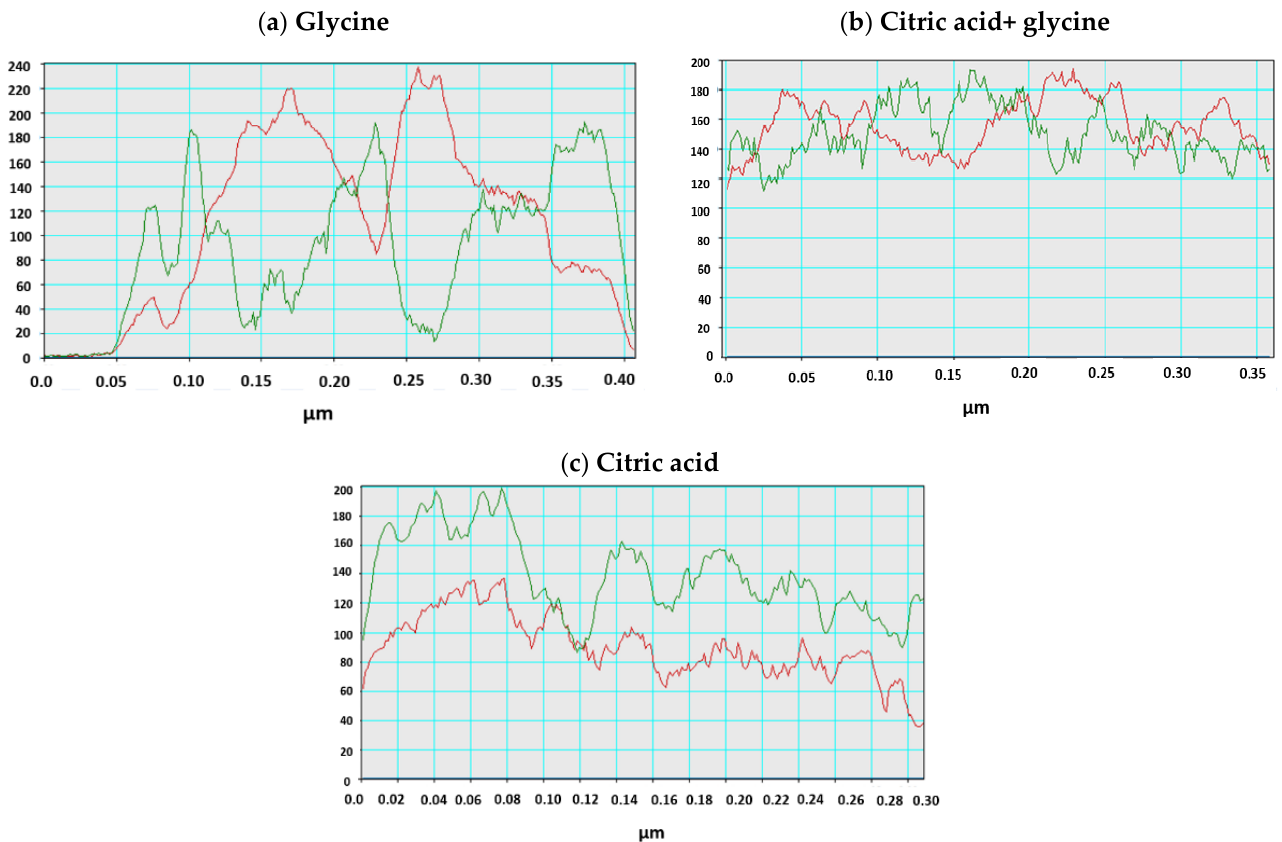
Figure 5. La- and Fe-concentration profiles of core-shell materials CS-4 ( a ); CS-3 ( b ) and CS-5 ( c ). La- green, Fe-red.